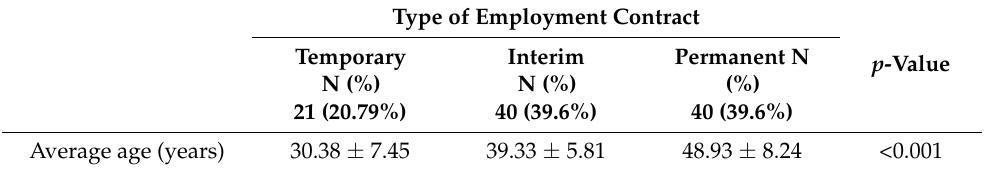
Table 1. Working situation and age of nurses.